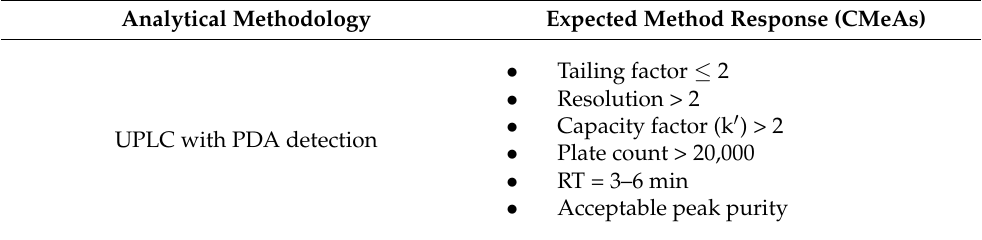
Table 1. Analytical target profile for hexoprenaline assay of injectable dosage